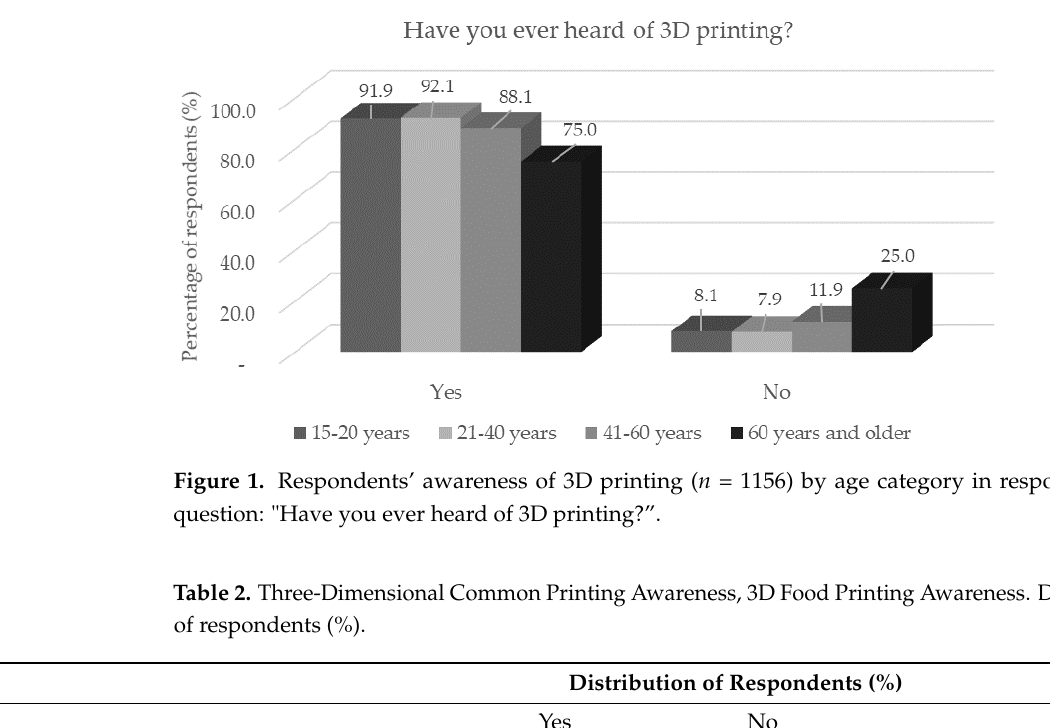
Table 2. Three-Dimensional Common Printing Awareness, 3D Food Printing Awareness. Distribu- tion of respondents (%).